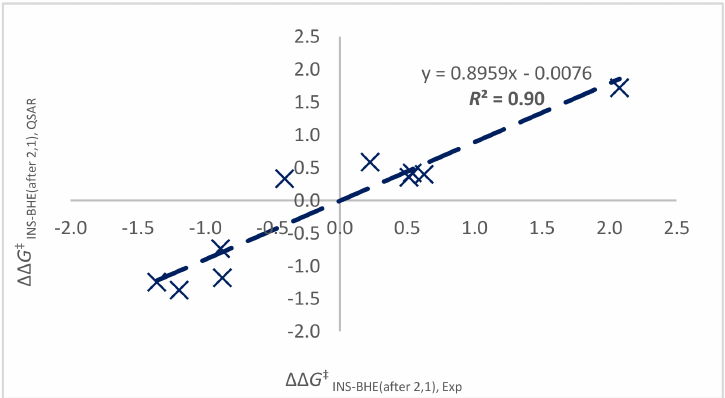
Figure 4. Correlation of experimentally observed ratio of 2,1 to 1,3 insertions (modeled as ∆∆ G ‡ ◦ C and QSAR-predicted amount ( ∆∆ G ‡ 2,1INS-BHE, Exp ) at 100 2,1INS-BHE, QSAR ) for catalysts Hf-1 to Hf-5 and Zr-1 to Zr-5